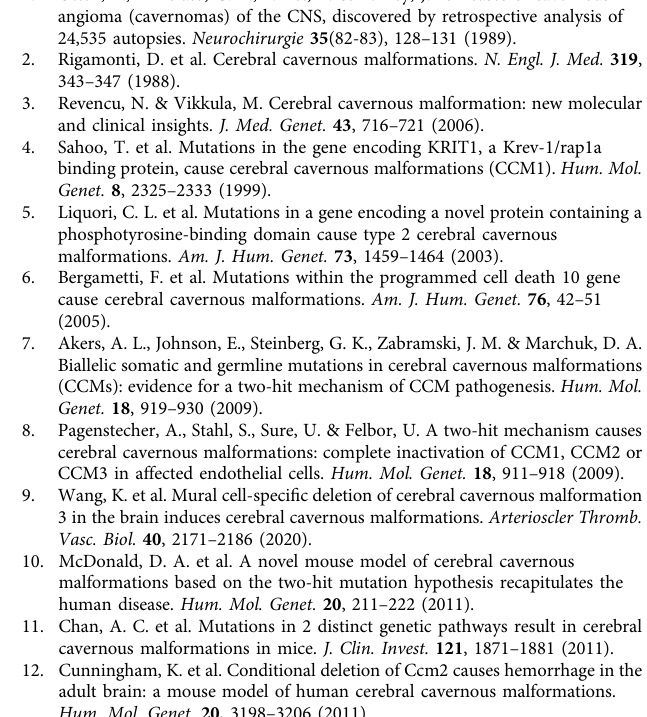
Cell culture and growth factors . HBMVECs (cAP0002) were purchased from Angio-Proteomie (Boston). ECs were grown in Microvascular Endothelial Cell Growth Medium-2 MV (EGM2, Lonza).